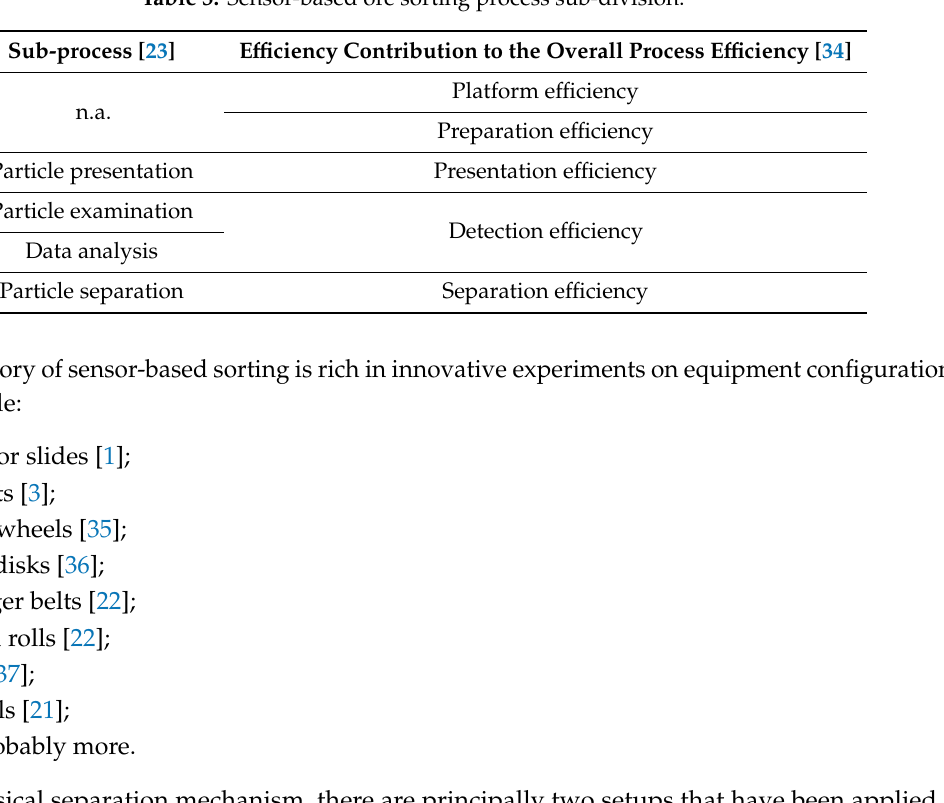
Table 3. Sensor-based ore sorting process